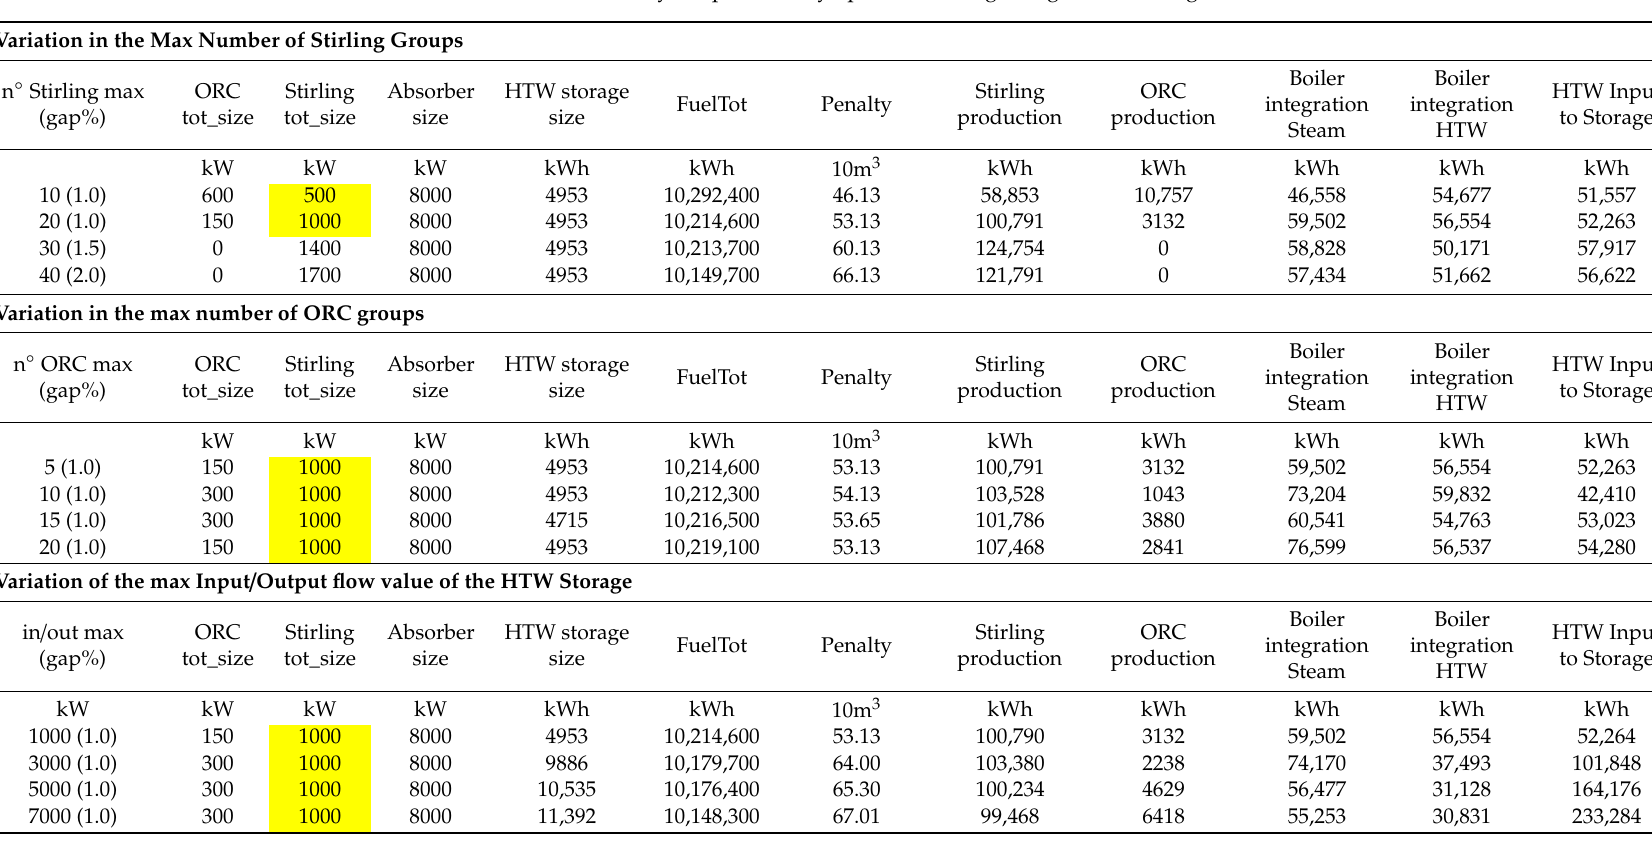
Table 4. Main results obtained by the preliminary optimization, agreeing with the ranges of Table